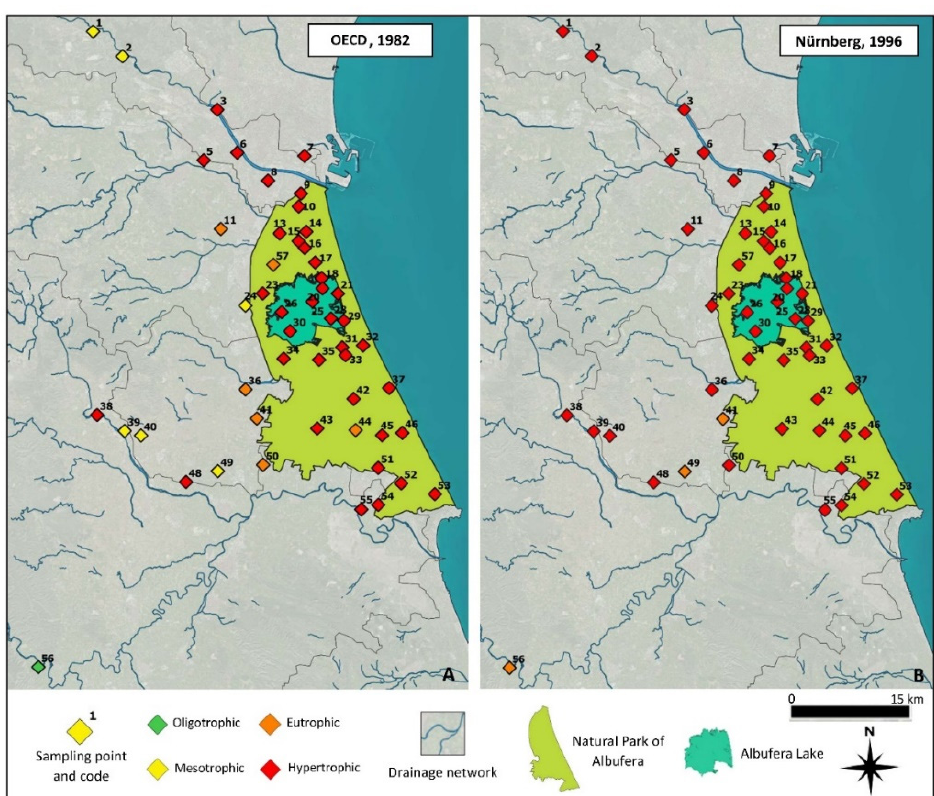
Figure 5. Study area with the spatial distribution of the sampling points classified according to their trophic status. ( A ) Evaluation according to OECD [68], ( B ) evaluation according to Nürnberg [69]. Base image: OrtoPNOA 2018 CC-BY 4.0 scne.es.